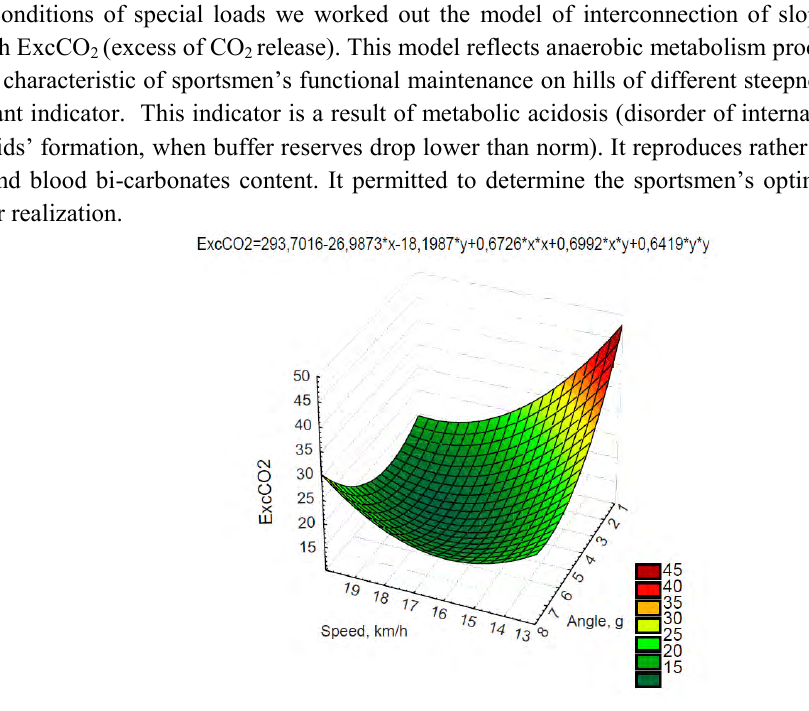
Fig. 5. Model of ExcCO 2 interconnection of ski-racers with hills’ climbing speed and slope